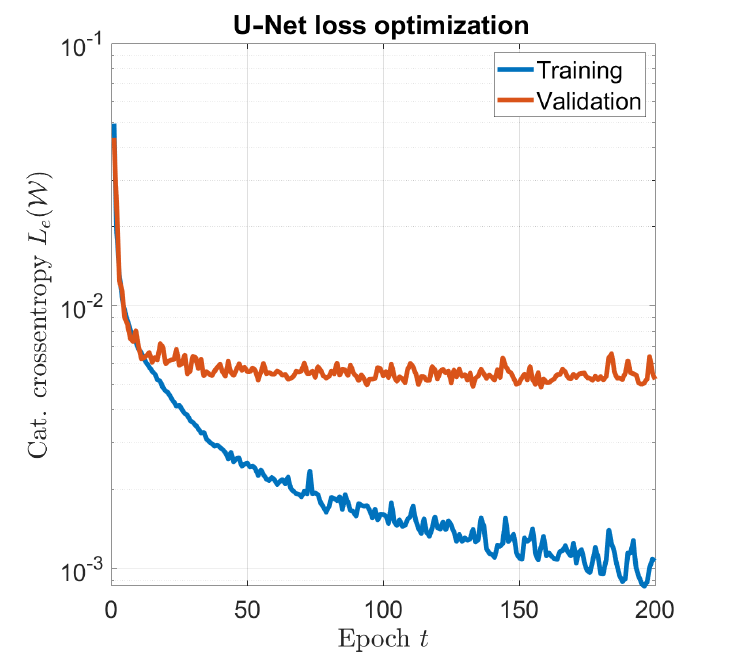
Figure 2. U − Net optimization: training and validation